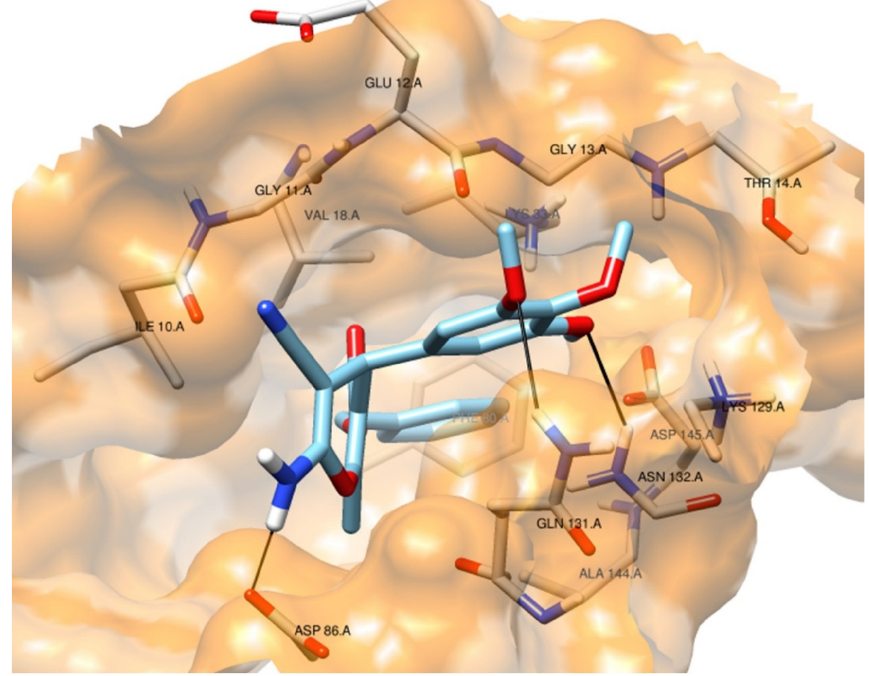
Figure 9. Three-dimensional model of binding interactions of compound 4d after docking calculations in the ATP binding pocket of CDK2. Hydrogen bond (black lines), hydrogen atoms (white), nitrogen atoms (blue), and oxygen atoms (red).